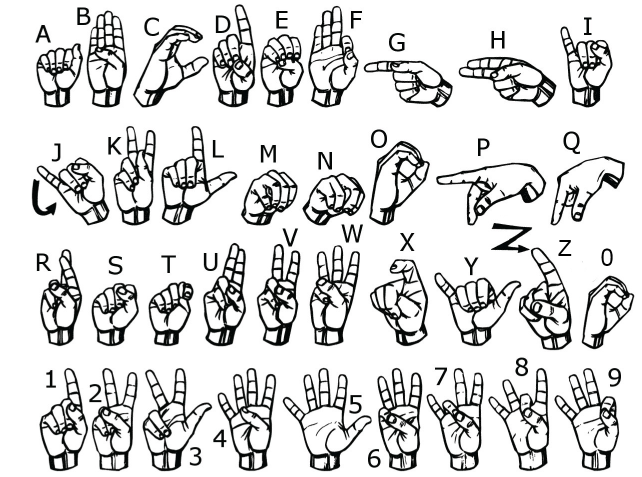
Figure 1. Fingerspelling in American Sign Language which represents 26 letters and 10 digits with different patterns of fingers and handshapes